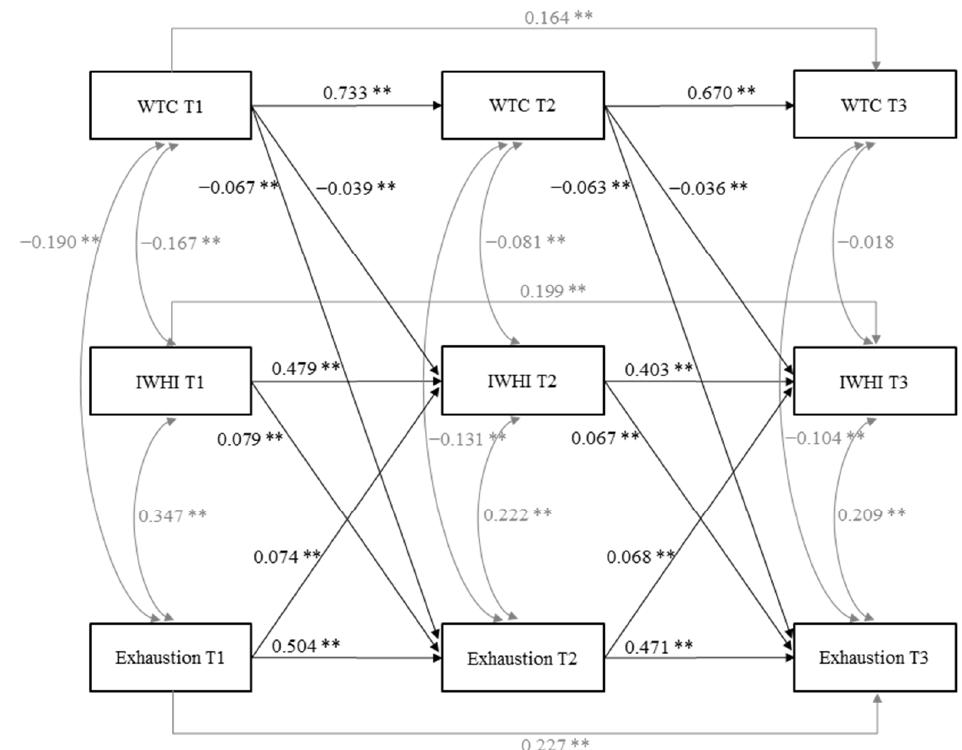
Figure 2. Final model (M5) with standardized coefficients for WTC, IWHI, and exhaustion. For clarity, control variables (gender, age, education level, living with a partner, underage child in household, weekly working hours, regular day work, and requirement level) are not shown. * p < 0.01. ** p <